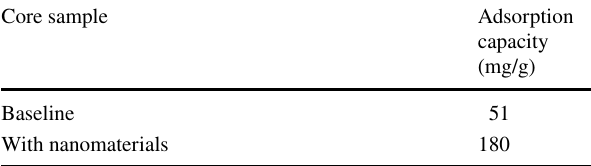
Table 3 Adsorption capacity of EDTA on core